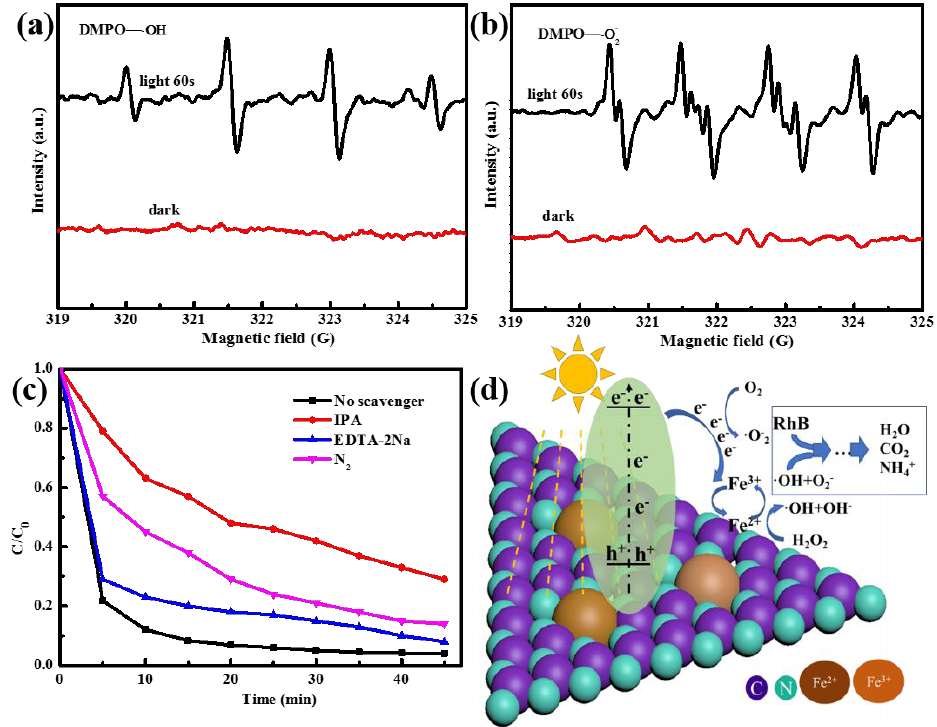
Figure 6. RhB degradation curves with different scavengers over 2 nd Fe–g–C 3 N 4 ( a ), EPR spectra of DMPO/•OH ( b ), EPR spectra of DMPO/•O 2− ( c ), and a schematic illustration of mechanism ( d